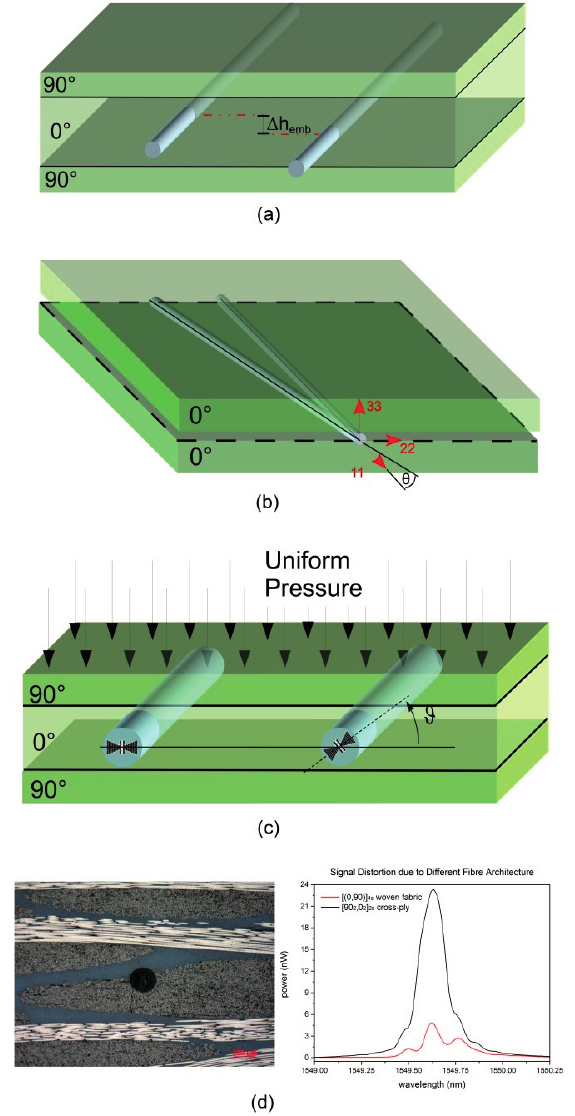
Figure 1. Schematic representation of ( a ) mal-positioning through thickness during embedding; ( b ) misalignment between sensor and reinforcing fibres direction on a UD layup; ( c ) orientation of a micro-structured MOF being controlled during laying down and ( d ) influences of the fibre architecture on the sensor readout: (left) polished cross section of a 125 µm fibre optic embedded in a 5-harness satin woven fabric Carbon-PPS laminate. (right) Peak distortion of the reflected signal for an FBG embedded in a Carbon PPS [(0,90)] 4s laminate and comparison with the reflected spectra of an FBG embedded in a cross-ply [90 2 ,0 2 ] 2s glass fibre reinforced